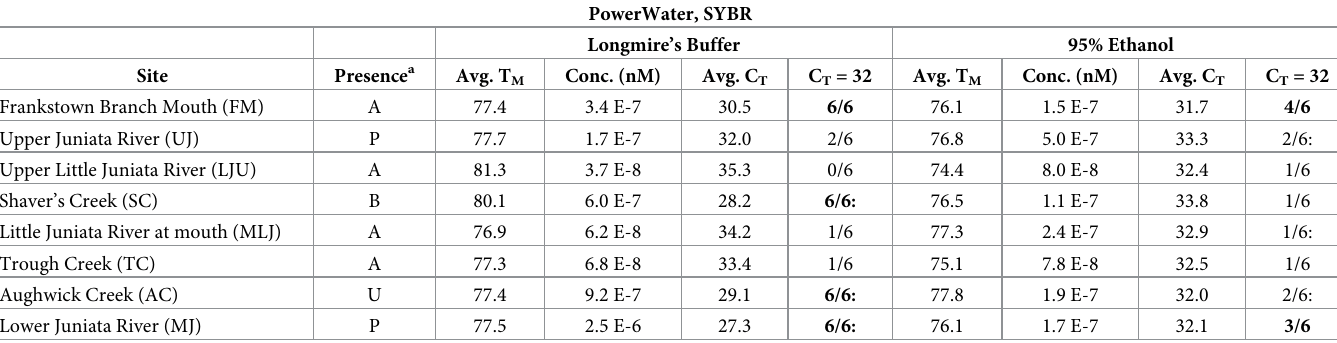
Table 5. Qiagen’s PowerWater extraction kit with a SYBR Green qPCR